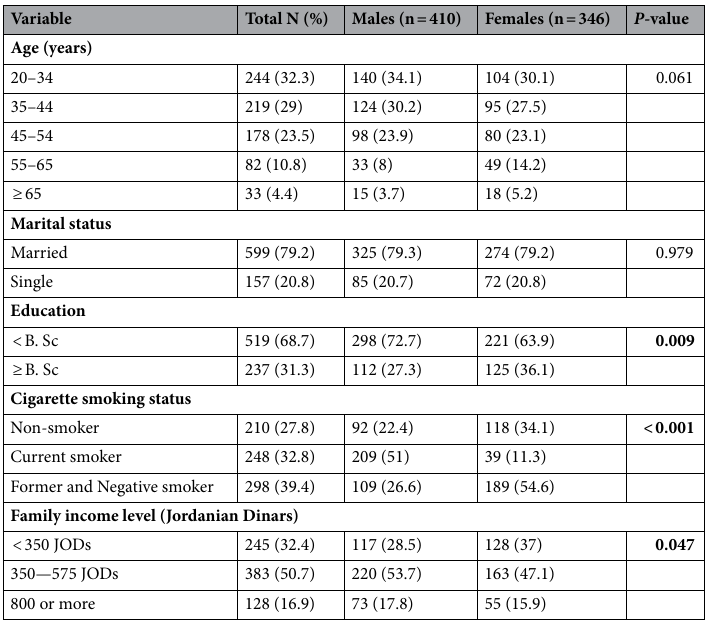
Table 1. Characteristics of the study population stratified by gender. Data are presented as Numbers and Percentages (N (%)). Chi-square test was performed to test the differences between genders. B.Sc. Bachelor’s degree. *P < 0.05 in the comparison between Males and Females. Significant values are in bold.